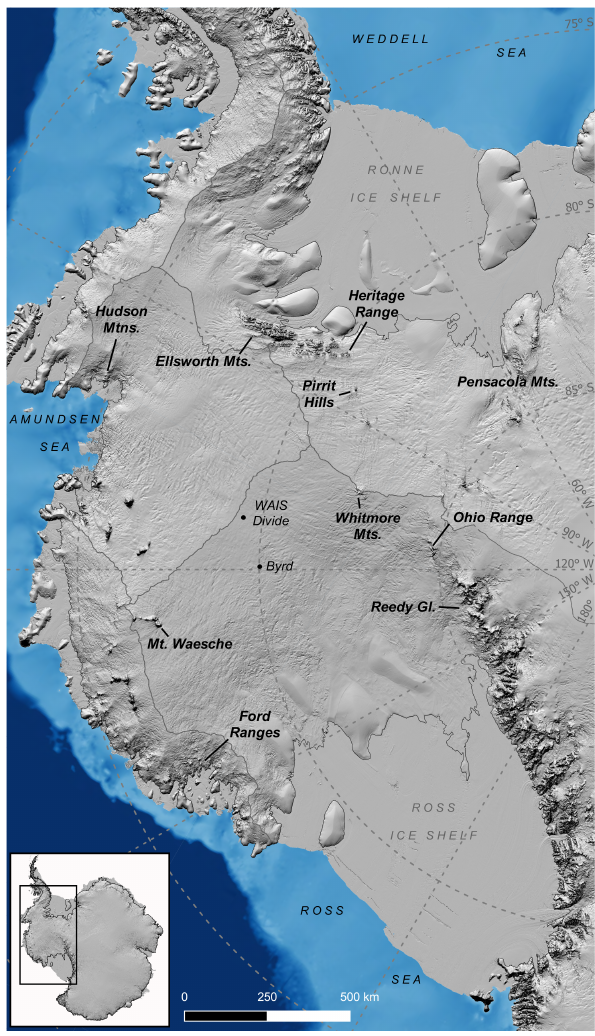
Figure 1. Map of West Antarctica. Hillshade of ice-sheet surface to- pography (Howat et al., 2019) is vertically exaggerated 20 × and is overlaid on marine bathymetry (Fretwell et al., 2013). The continen- tal shelf is shown in light blue. The grounding line (Bindschadler et al., 2011) and major ice divides (Zwally et al., 2012) are traced in